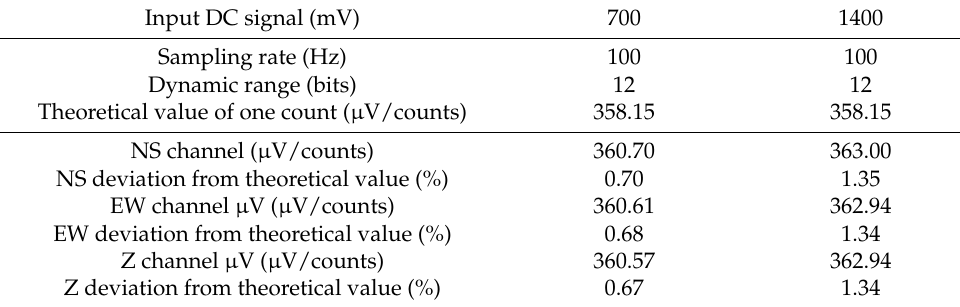
Table 7. Experimental accuracy results of the data acquisition system.